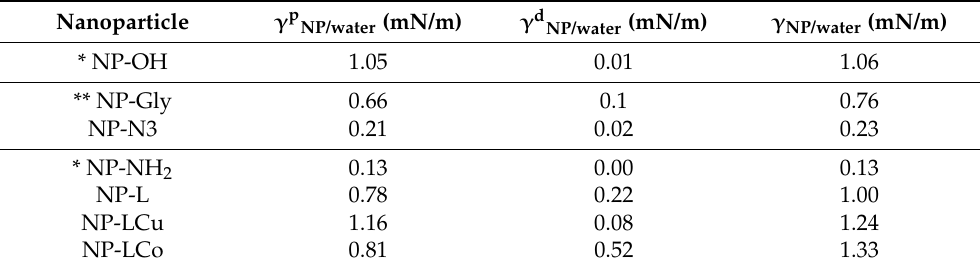
Table 1. Interfacial energies γ d , γ p of the NPs adsorbed at the interface calculated with the OWRK equation graphically represented in Figures 5 and 6.